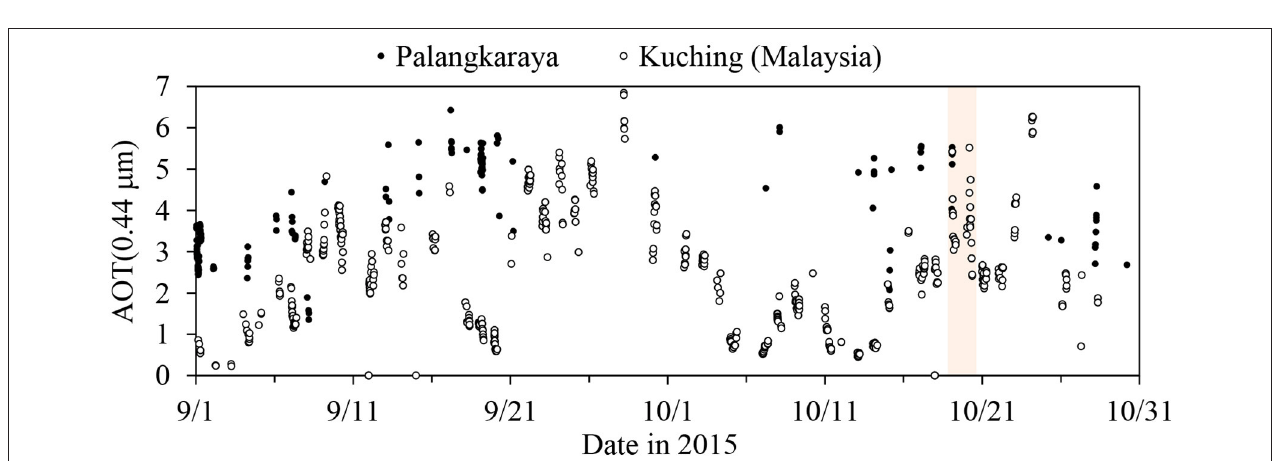
FIGURE 6 | The values of AOT at a wavelength of 0.44 µ m at NASA/AERONET sites Palangkaraya (Indonesia) and Kuching (Malaysia) in Southeast Asia in September and October 2015, denoted by the black dots and open circles,